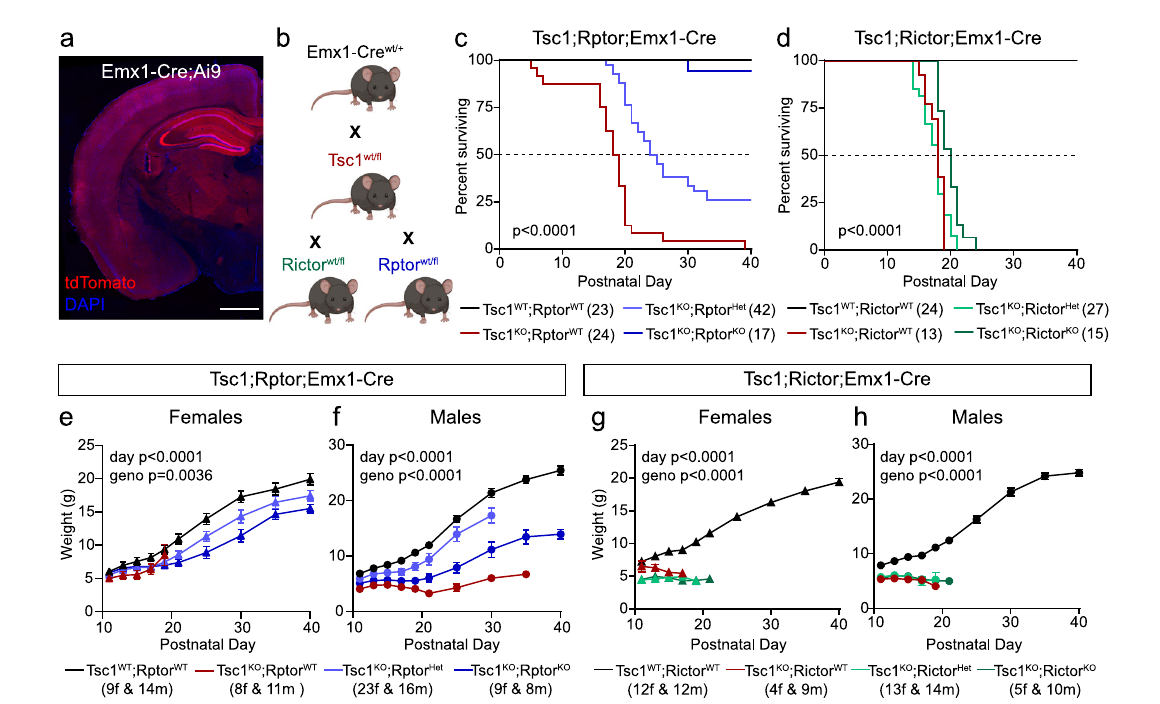
Fig. 4 | Reduction of Rptor prolongs the lifespan of Tsc1-cKO mice. a Representative image showing one hemisphere of a coronal section from an Emx1-Cre + ; Ai9 + mouse. The Cre-dependent tdTomato reporter is in red. DAPI labels cell nuclei (blue). This experiment was performed once. Scale bar = 1 mm. b Schematic of the crosses used to generate experimental mice. Emx1-Cre wt/+ mice were crossed with Tsc1 wtl/ fl mice. This line was then bred to either Rictor wt/ fl or Rptor wt/ fl mice. Created with BioRender.com. c , d Survival analysis of Tsc1;Rptor;Emx1-Cre ( c ) and Tsc1;Rictor;Emx1-Cre ( d ) mice of the indicated genotypes. The starting number of mice for each genotype is indicated in par- entheses. Dashed lines indicate 50% of the population surviving. P values from Log-rank Mantel – Cox tests are shown. e – h Mean ± SEM body weight in grams